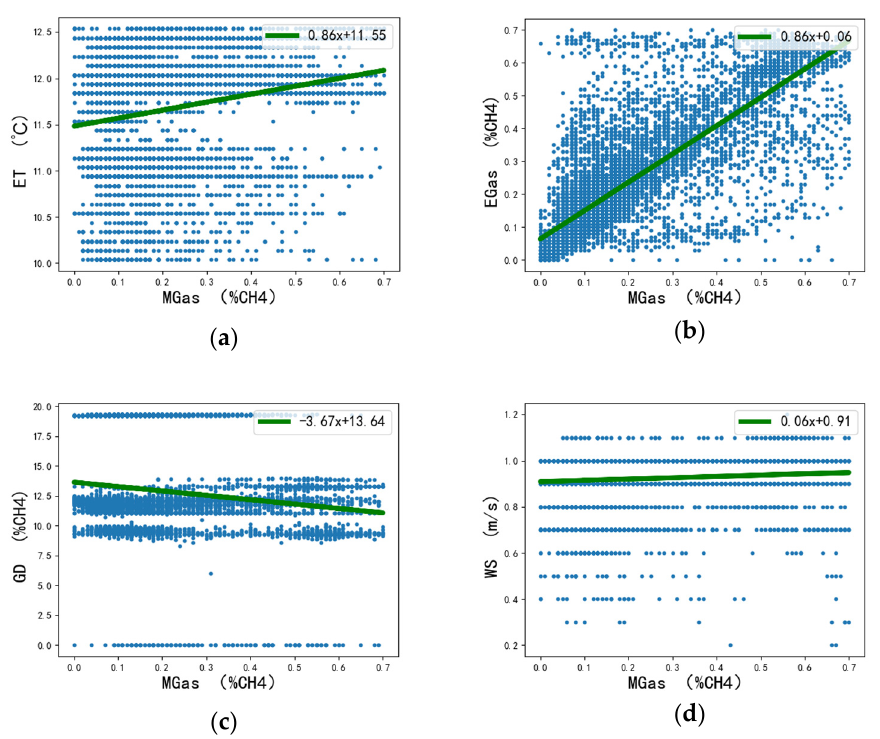
Figure 4. Correlation analysis of data.